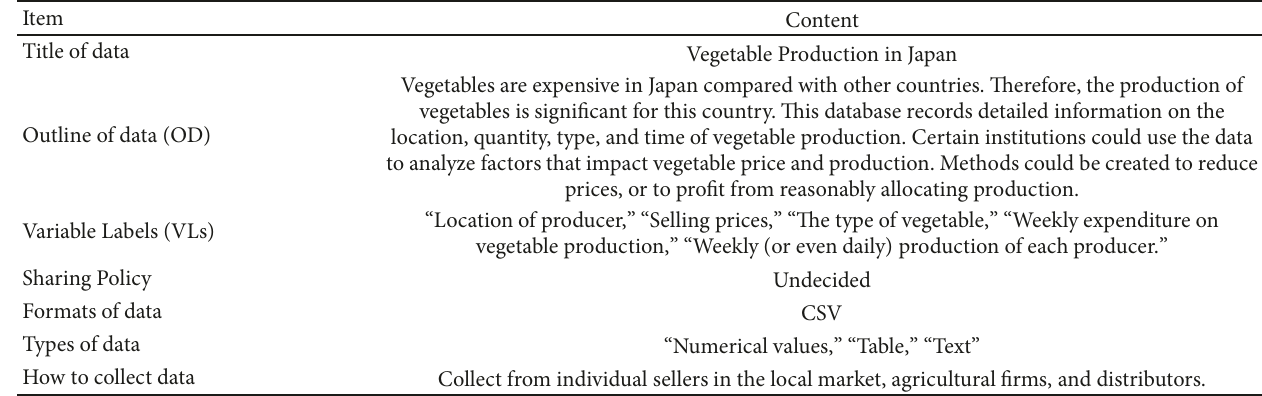
Table 1: An example of DJ and VLs.